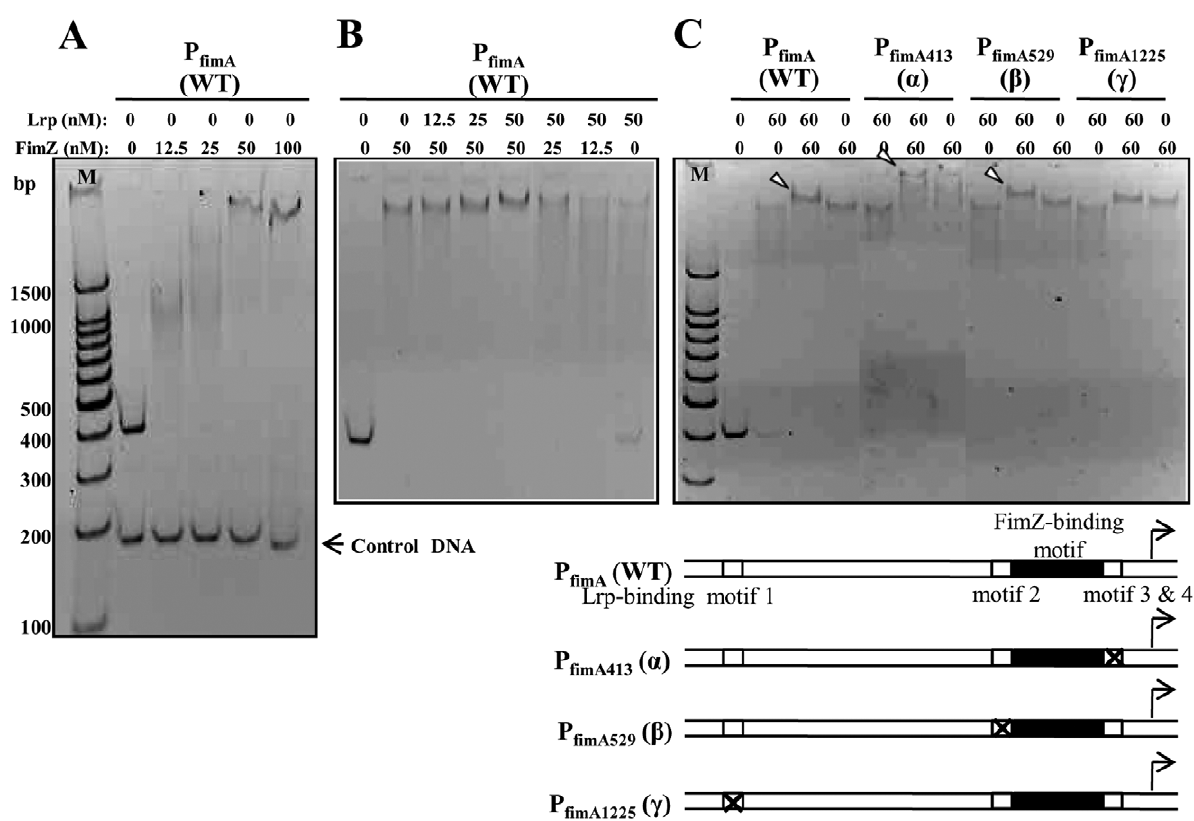
Figure 7. Binding of the purified Lrp and FimZ proteins to P fimA . (A) Binding of FimZ to P fimA (WT). (B) Binding of Lrp and FimZ to P fimA (WT). (C) Binding of Lrp and FimZ to P fimA (WT), P fimA413 ( a ), P fimA529 ( b ), or P fimA1225 ( c ). The white arrowheads indicate super-shifted Lrp-P fimA -FimZ complexes. To enhance resolution of the super-shifted DNA-protein complexes, the running time of the polyacrylamide gel in panel C was extended from 1 h (used in panels A and B) to 2 h. Schematic diagrams of the wild-type and mutant fimA promoters are shown under the gel.